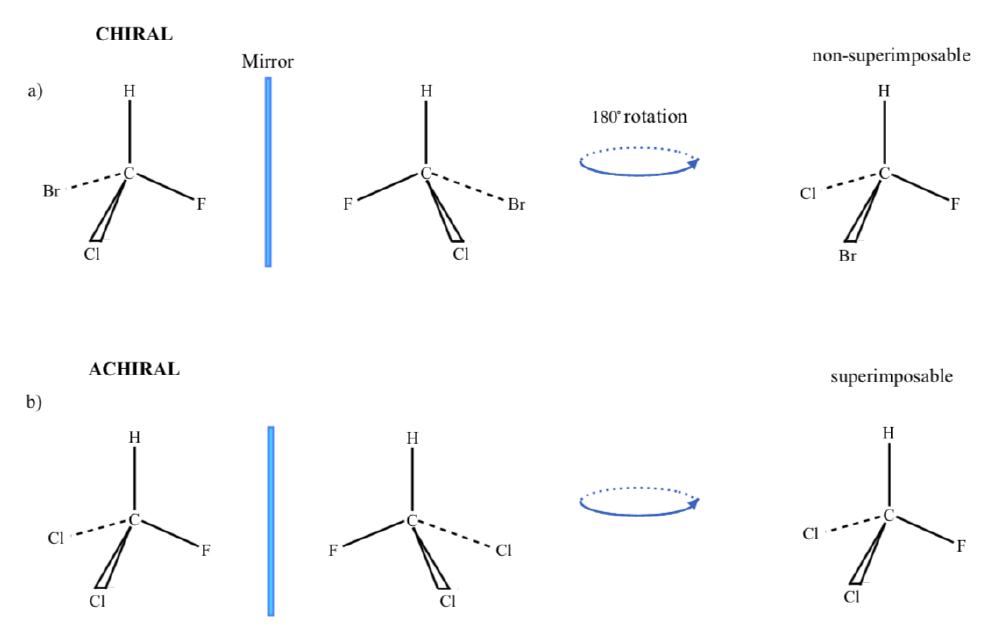
Figure 1. ( a ) The molecule bromochlorofluoromethane is chiral, as the molecule and its mirror image cannot be superimposed, even after rotation. ( b ) Dichlorofluoromethane, on the other hand, is achiral, as the molecule can be superimposed upon its mirror image after